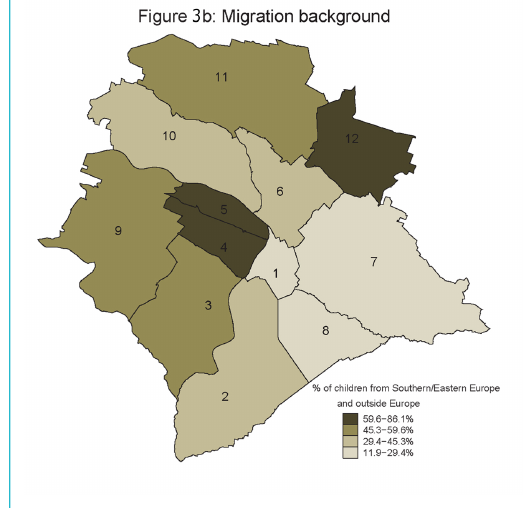
Table 2: Weight status trajectories in all children (n = 7145) and in specific strata.